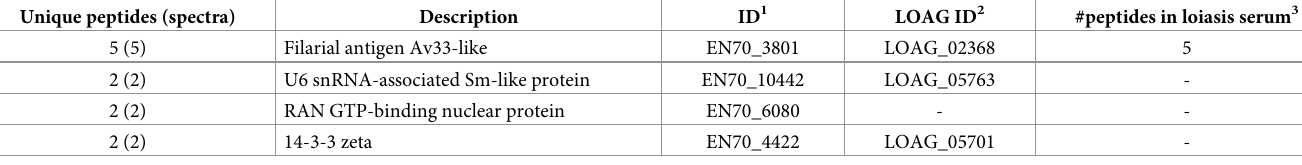
Table 5. Proteins identified in L5 stage L . loa e xcretory/secretory